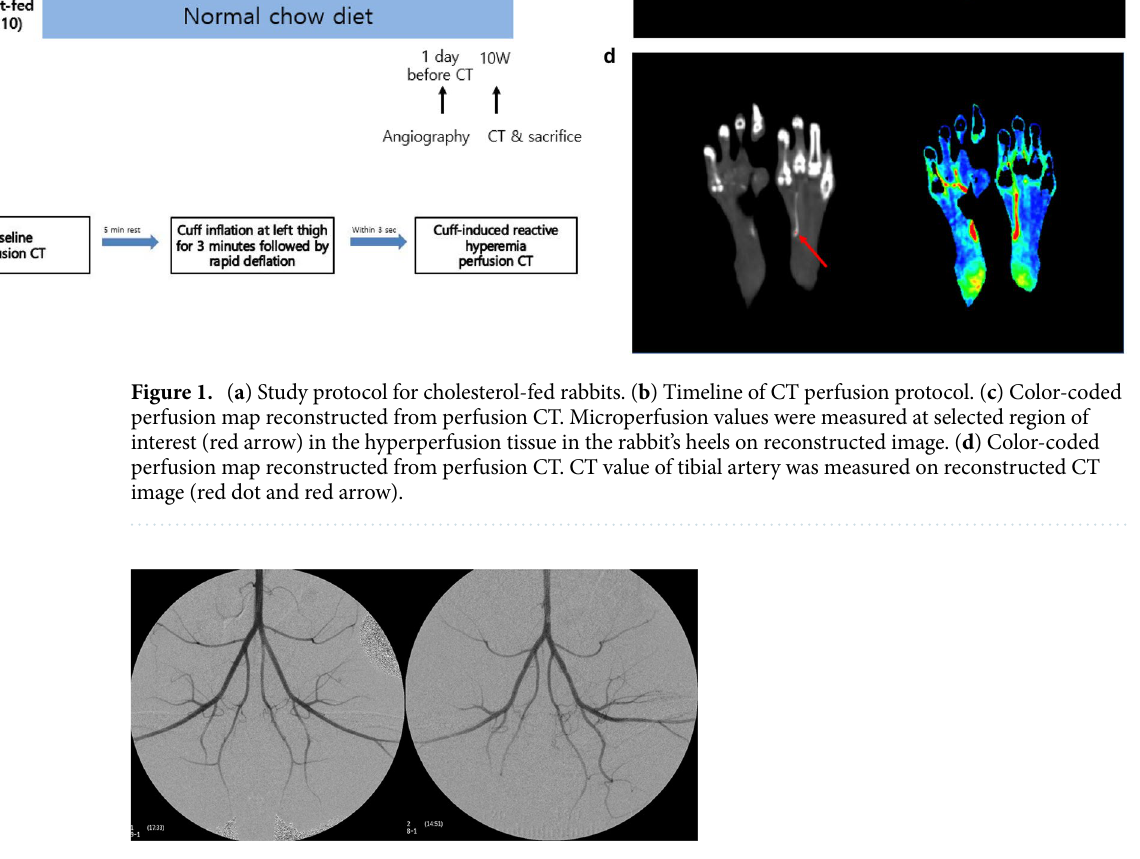
Figure 2. Angiography of chow-fed rabbits (left) and cholesterol-fed rabbits (right). Compared to chow-fed rabbits, mild luminal irregularity in the aortoiliac arteries were observed in cholesterol-fed